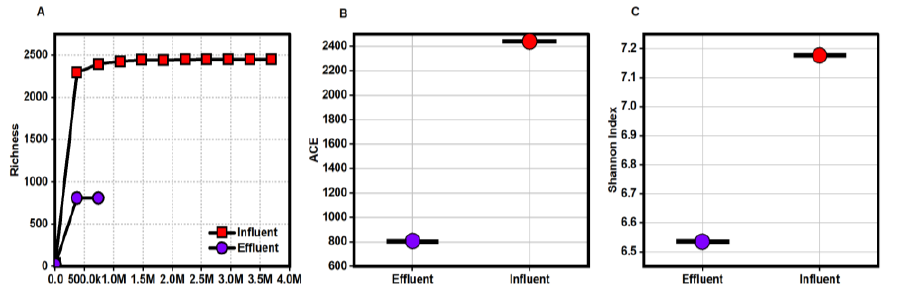
Figure 1. Analysis of metagenomics sequence diversity of samples, visualized by Origin 2022. ( A ) Sparsity curve analysis of influent and effluent samples; ( B ) ACE analysis of influent and effluent samples; and ( C ) Shannon analysis of influent and effluent samples.